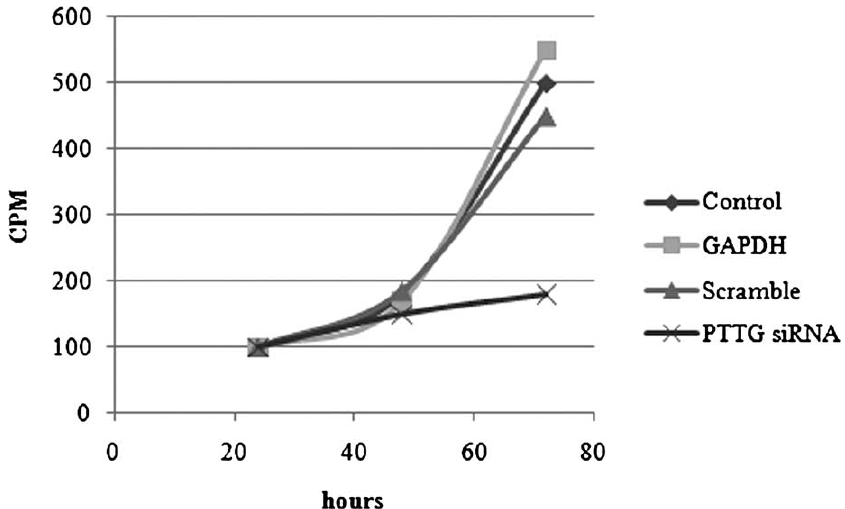
Fig. 5. Effect of PTTG1 silencing on [ 3 H]Thy incorporation in TT cells. Panel A: TT cells were transfected with PTTG1 siRNA #1 and #3, positive control GAPDH siRNA or negative control scramble siRNA, and cultured for up to 72 h. DNA synthesis was evaluated by measuring [ 3 H]Thy incorporation (cpm) in at least 3 independent experiments in transfected and in control untransfected cells (Control) after 48 and 72 h. Results were calculated as average counts per minute of quadruplicate wells ±